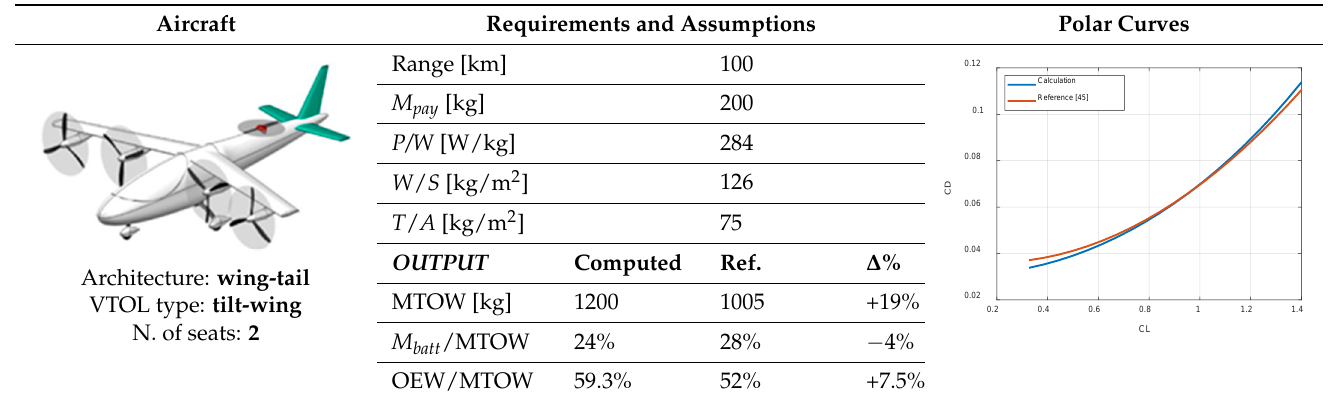
Table 6. Comparison with the four-passenger configuration of the reference paper [45].